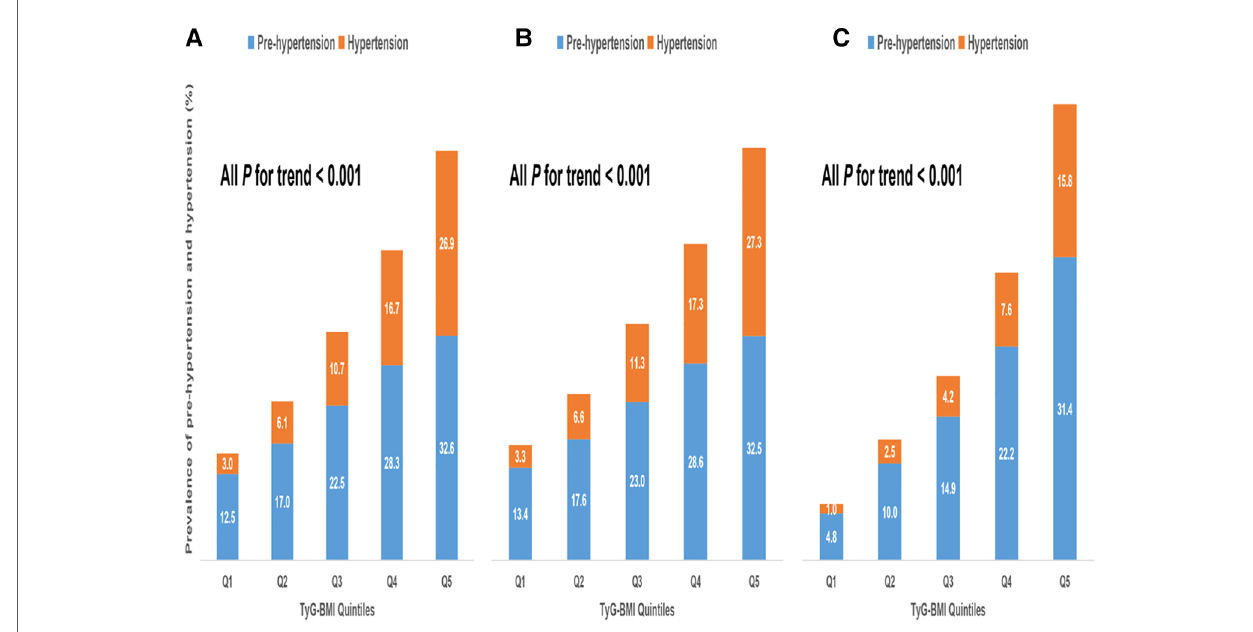
FIGURE 2 Prevalence of prehypertension and hypertension according to TyG-BMI group. ( A ). All populations ( B ). Chinese ( C ).